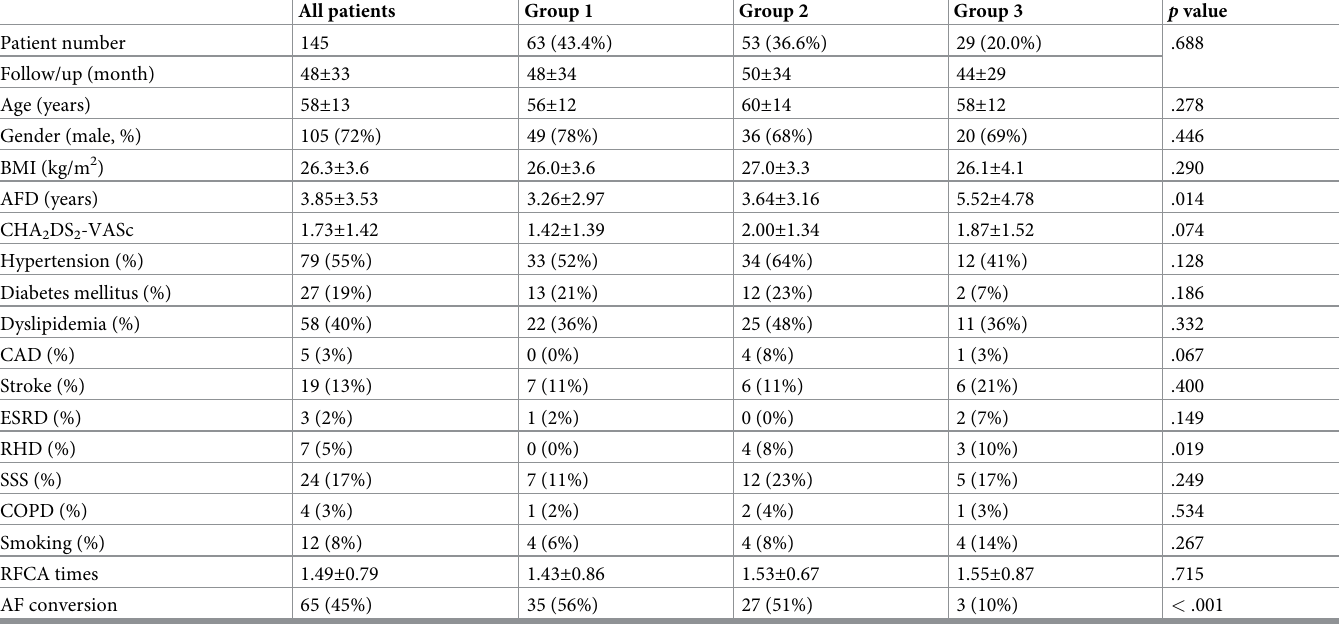
Table 1. Baseline characteristics, clinical data, and ablation results of the study groups. All